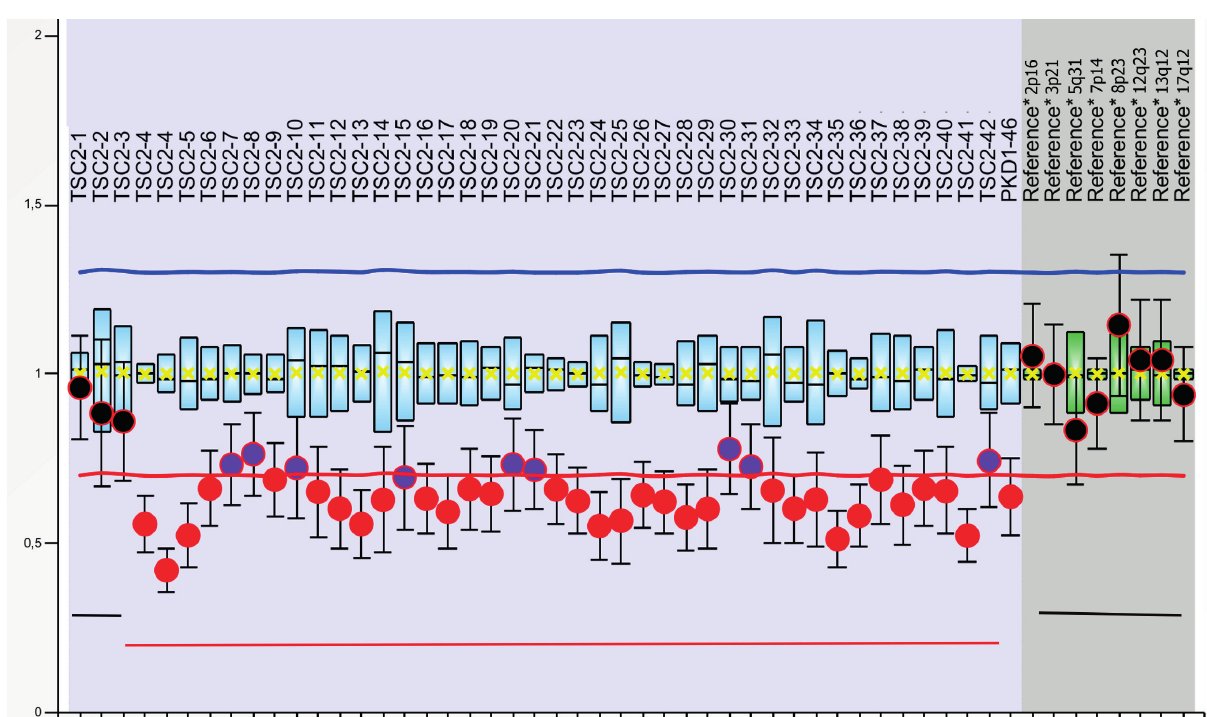
Fig. 2. The ratio chart displays results of MLPA analysis of TSC2 (P046-C1 TSC2, Lot C1-0315, MRC Holland), analysis was performed by Coffalyser software. Analysed DNA was isolated from cardiac rhabdomyoma tissue (foetus from second pregnancy of proband’s mother). In the case of clear deletion, signal of probe (red dots) lies below the red line. There is a deletion of exons 4-42 of TSC2 and at least exon 46 of PKD1 . Partially reduced signal of some probes (the exons 7, 8, 10, 15, 20, 21, 30, 31 and 42 of TSC2 , purple dots) represent heterogeneity of cardiac tissue – tumour cells could not be entirely separated from cells of normal heart tissue. This finding demonstrates presence of the second hit (loss of heterozygosity) in TSC2 in foetal cardiac rhabdomyoma. The red straight line in the bottom of the picture represents schematic extent of TSC2/PKD1